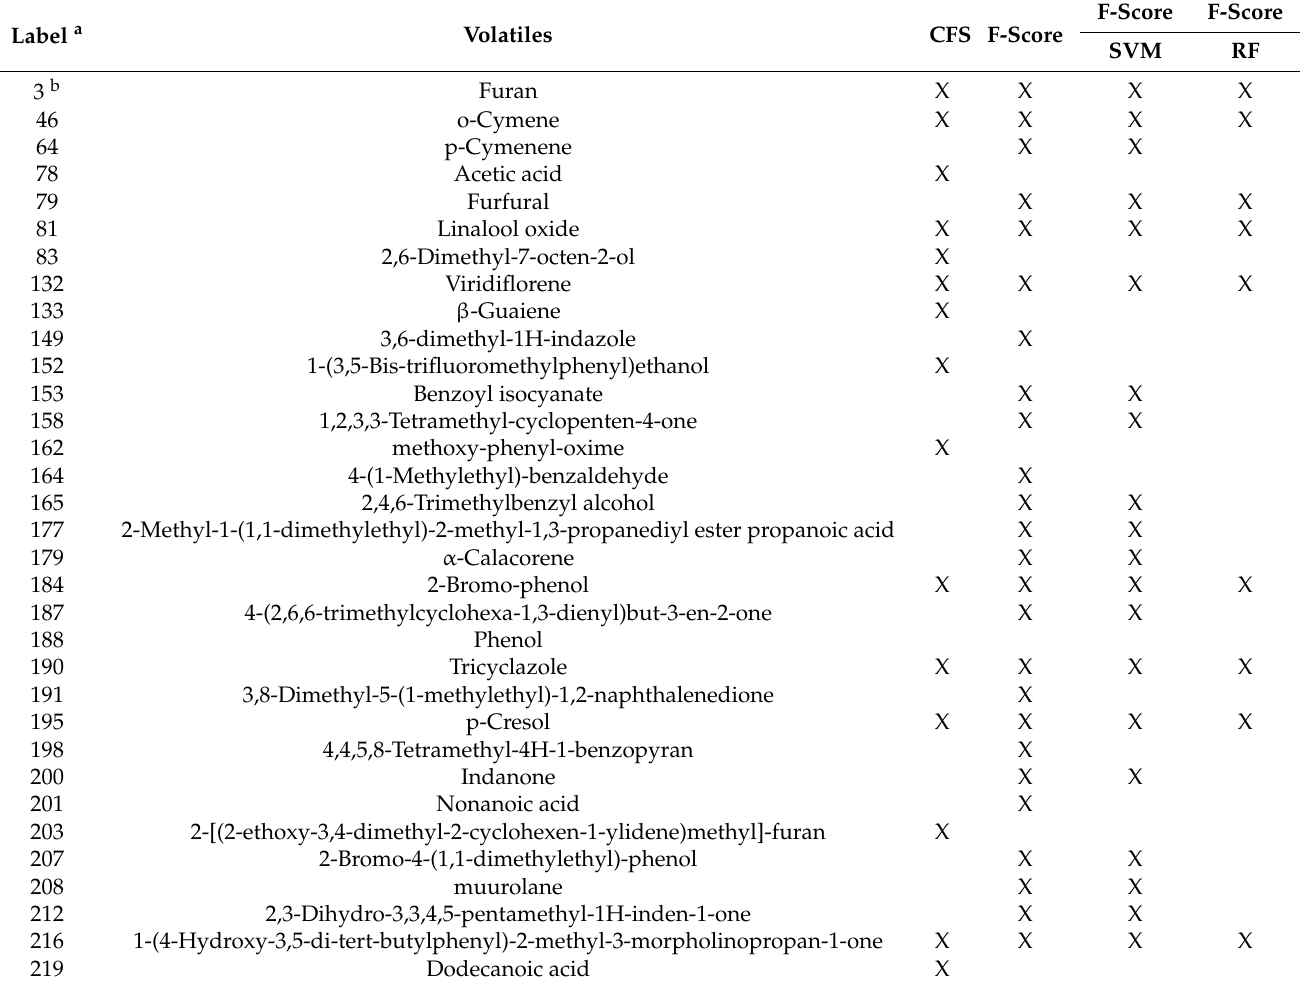
a Number of identified uVOM, listed in Table S1 (Supplementary Material); b uVOMs indicated in bold were simultaneously reported as the most important using the different CFS and F-score upon SVM, allowing the discrimination of the target groups with 100% accuracy using SVM and